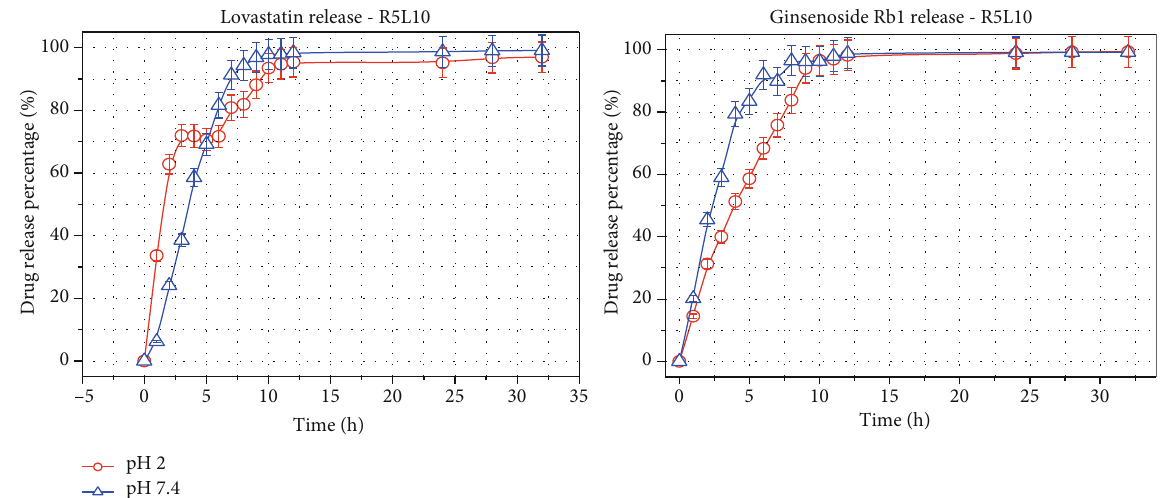
Figure 11: Percentage of Lov and ginsenoside Rb1 released from NPB-R5L10 sample in pH 2 and pH 7.4 solutions.